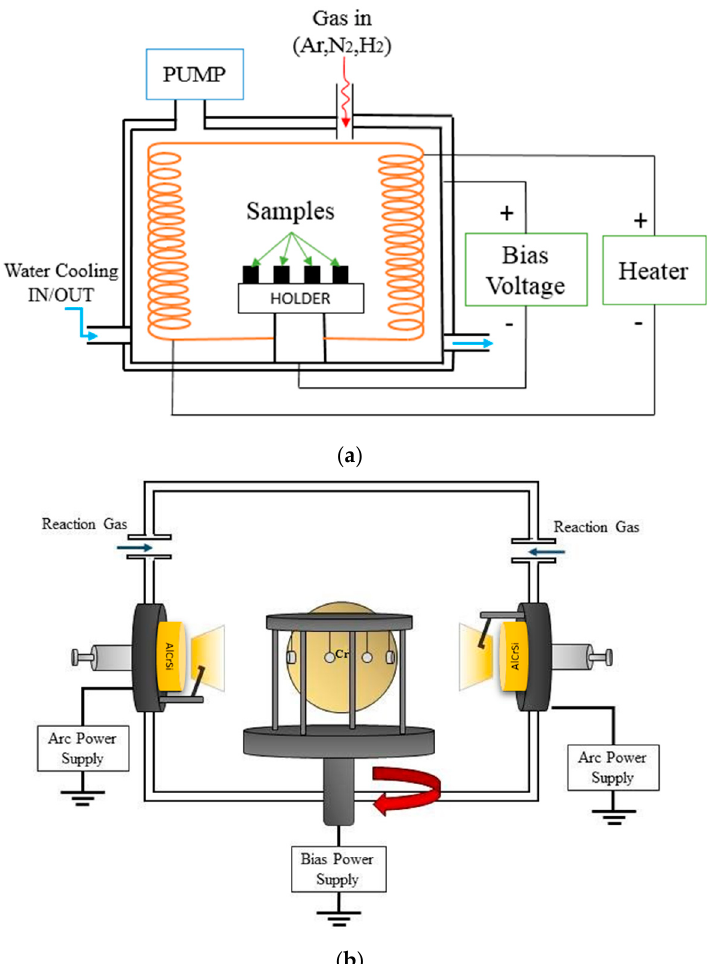
Figure 1. ( a ) Schematic diagram of plasma nitriding setup and ( b ) schematic diagram of physical vapor deposition (PVD) cathodic-arc evaporation system.